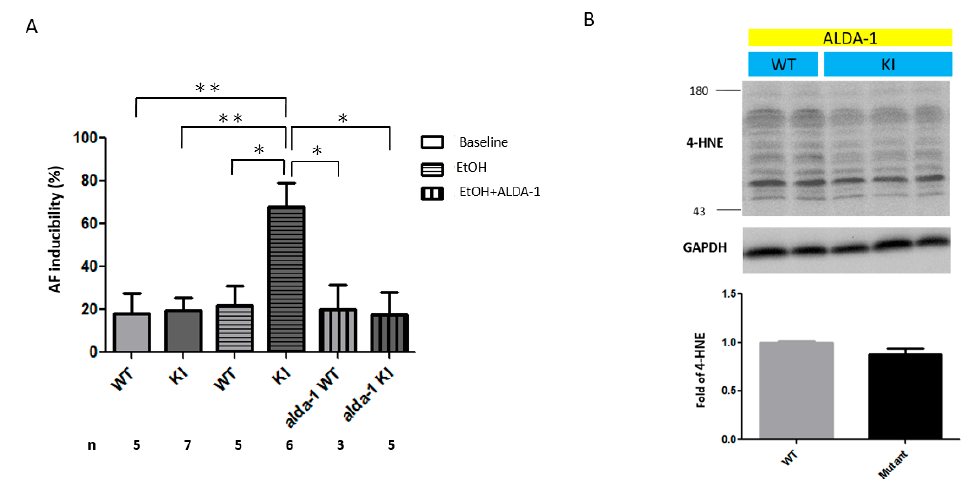
Figure 3. ( A ) E ff ect of transesophageal burst pacing on the occurrence of atrial fibrillation (AF) in wild-type and ALDH2*2 KI mice with chronic ethanol intoxication with and without Alda-1 treatment. ( B ) E ff ect of Alda-1 treatment on the production of 4-HNE in wild-type and ALDH2*2 KI mice with chronic ethanol intoxication. ( A ) The inducibility of AF was quantified by the ratio of pacing-induced AF episode in ten pacing bursts in each mouse ( n , the number of mice in each experimental group). ( B ) Representative Western blot and quantification relative to GAPDH of 4-HNE production in mice hearts. Each value represents the mean ± SE of at least three independent experiments. WT, wild-type; KI, heterozygous and homozygous ALDH2*2 KI mice; EtOH, ethanol; * p < 0.05, ** p < 0.01.